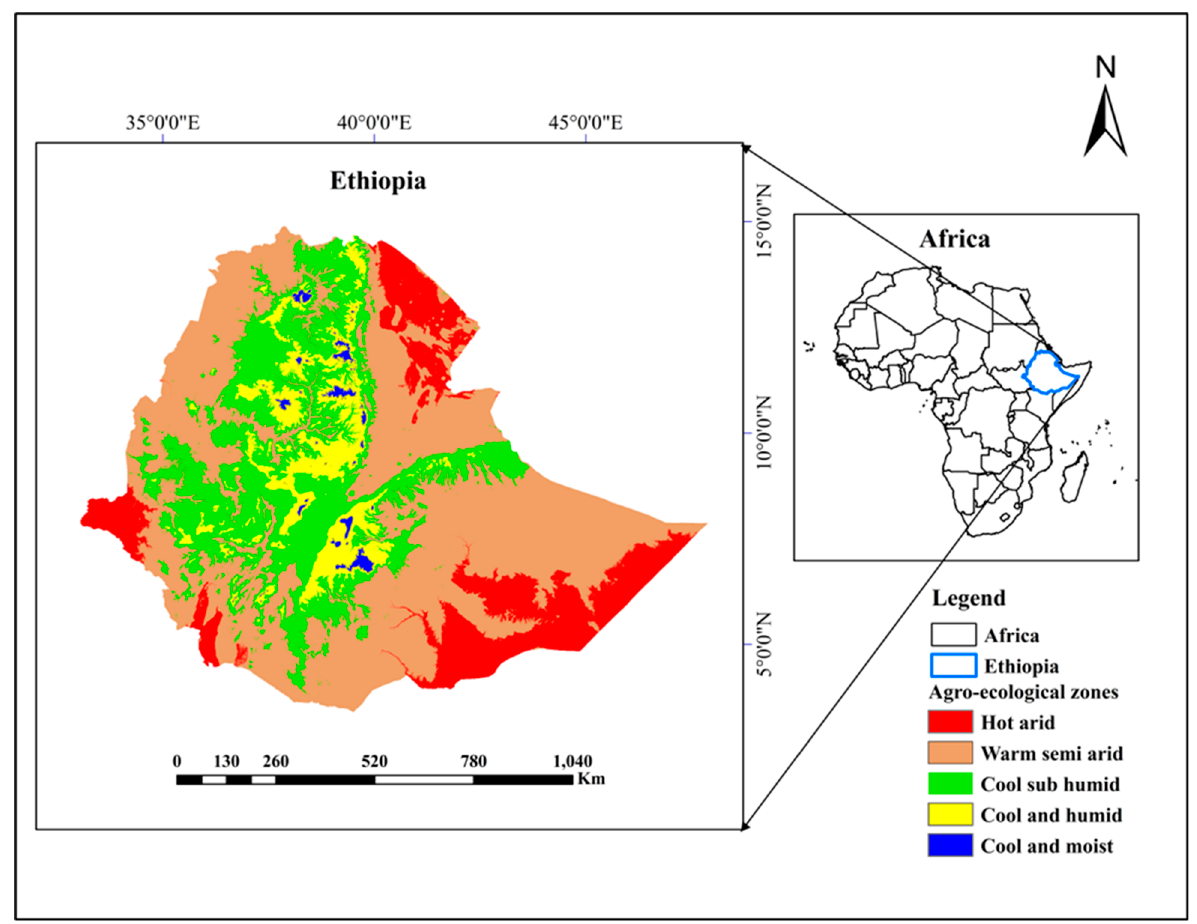
Figure 1. Location of the study area from Africa and its agro-ecological zones. According to the National Meteorology Agency (NMA), the Ethiopian lowlands are those below 1500 m of elevation, while the Ethiopian highlands are those above 1500 m, which make up 45% of the country [39]. The Ethiopian climate has three seasons. First, there is the main rainy season from June to September (JJAS), then the dry season from October to January (ONDJ), and finally the small rainy season from February/March to May (FMAM), locally referred to as Kiremt, Bega, and Belg, respectively [39]. The climate of the country is diverse and ranges from semi-arid deserts to humid and temperate